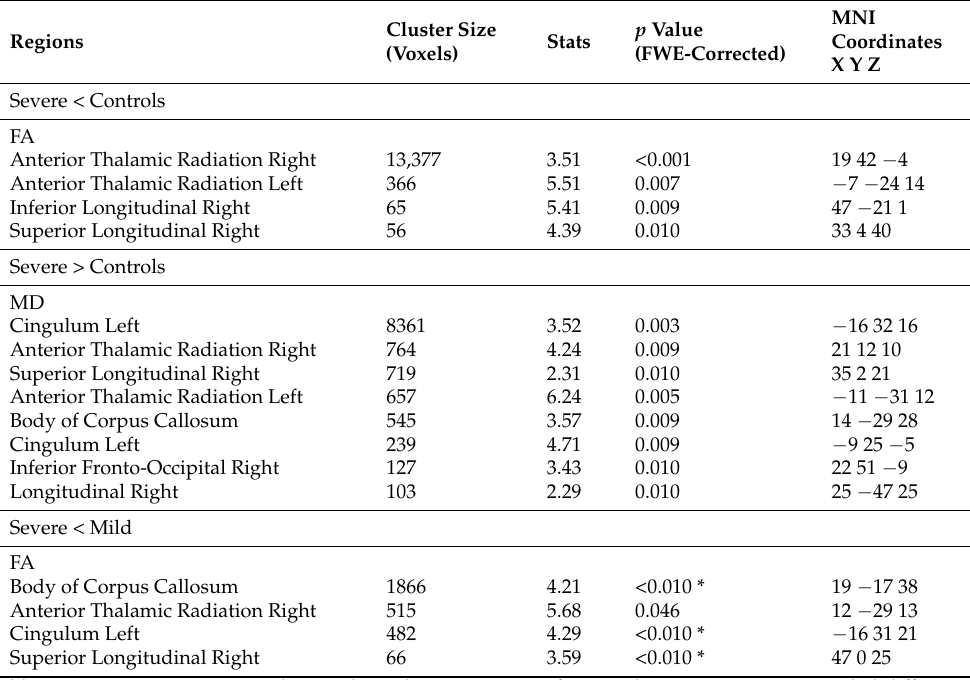
Table A2. White matter fractional anisotropy and mean diffusivity